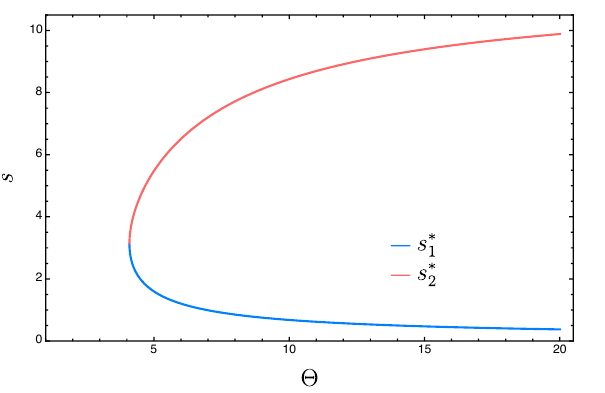
= 1.5 and ψ = 0.5. Recall that Θ ≡ σ P II for ψ I II 1,2